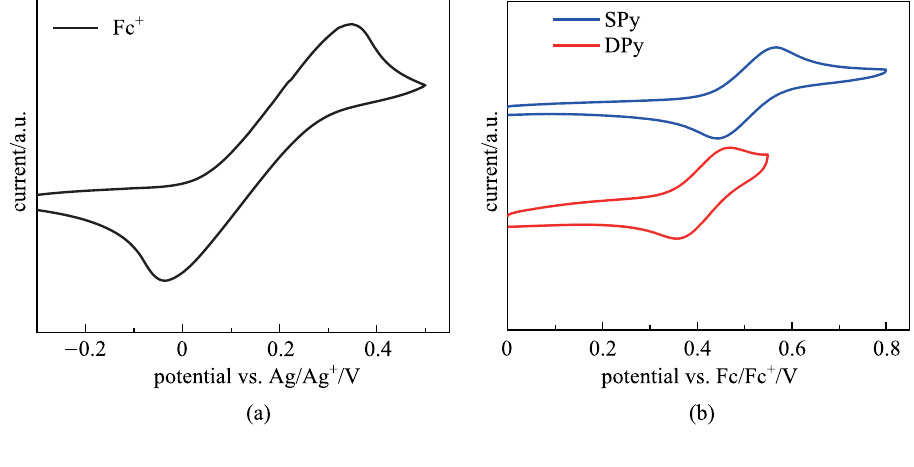
a T d was measured by TGA (corresponding to 5% weight loss) and toluene at 298K. c Absolute fluorescence quantum yield obtained in PMMA films (1 wt%). d HOMO was estimated from the CV. e LUMO = HOMO + E g opt . f Calculated from the onsets of fluorescence (FL, 77 K) and the phosphorescence (Phos, 77 K) spectra. g Measured in PMMA